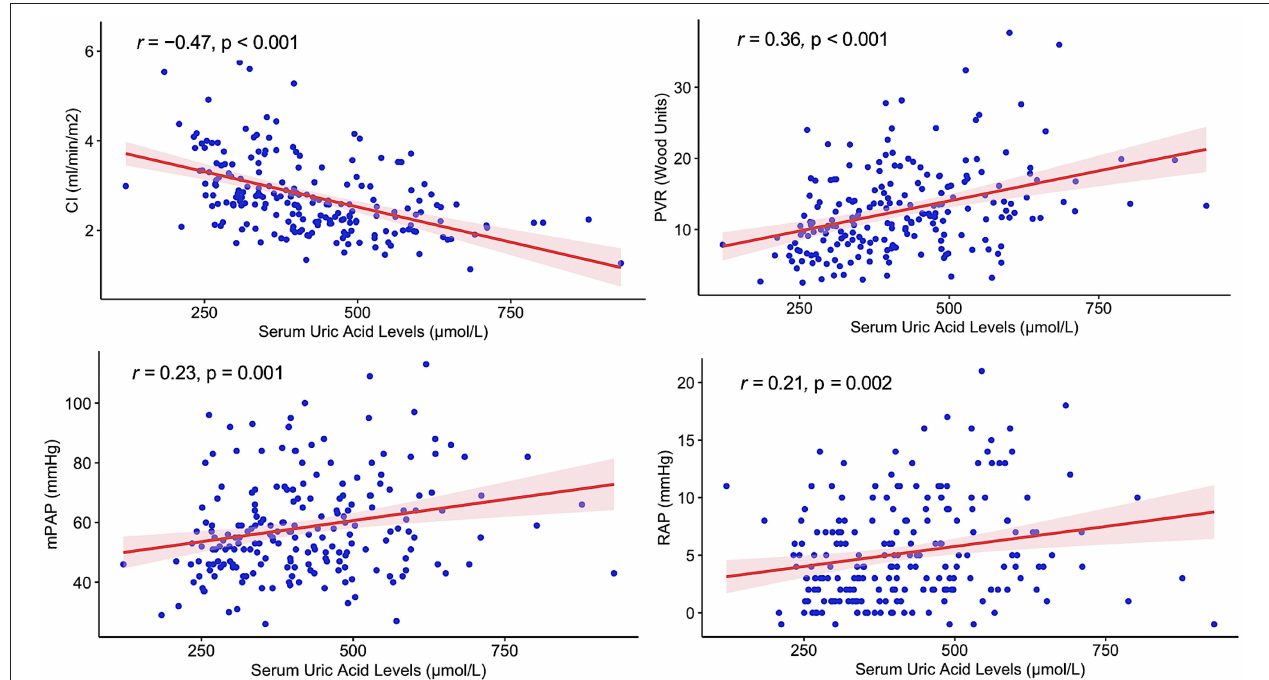
FIGURE 1 | Correlations between serum uric acid levels and hemodynamic parameters in patients with idiopathic pulmonary artery hypertension. CI, cardiac index; PVR, pulmonary vascular resistance; mPAP, mean pulmonary artery pressure; RAP, right atrial pressure.